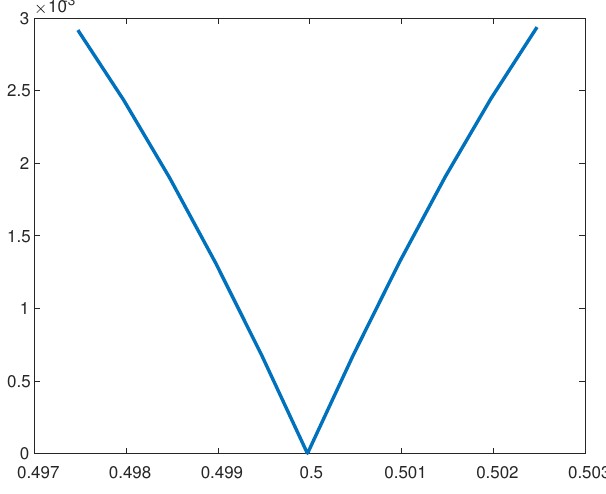
Figure 5. The graph of the error (cid:107) ˆ f − ˆ S (cid:107) as a function of s near s ∗ =